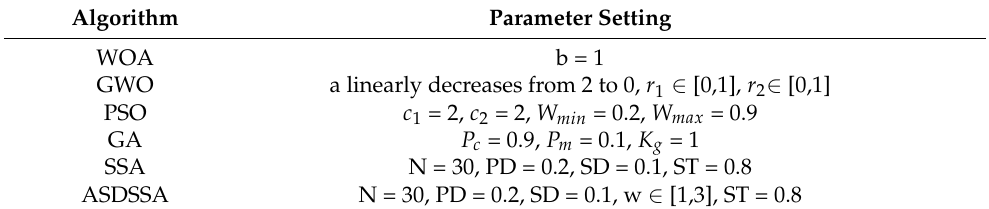
Table 1. Parameter settings.